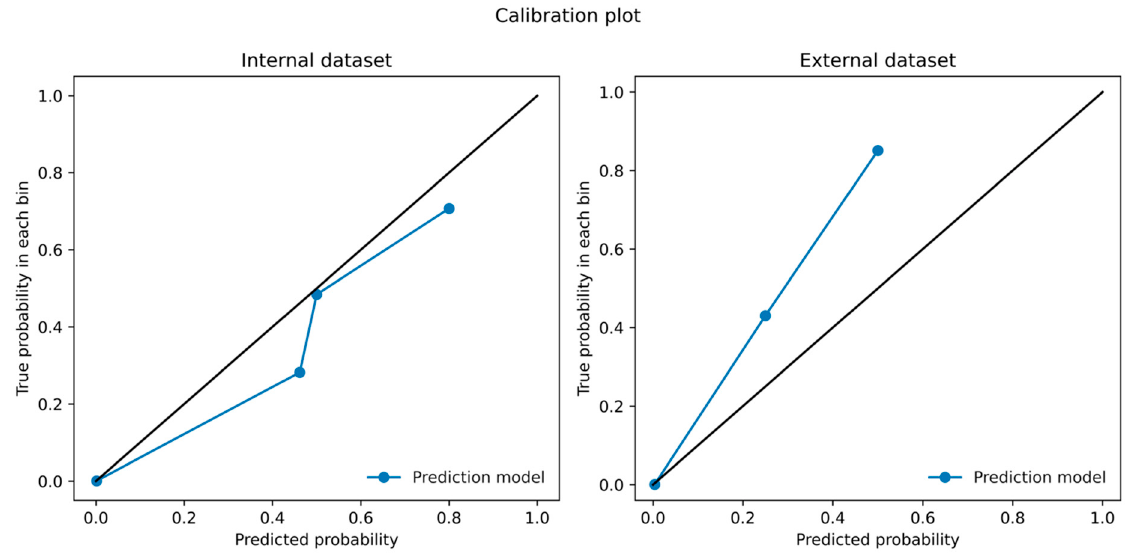
Figure 2. AUROC (area under the receiver operating characteristic curve) and AUPRC (area under the precision and recall curve) plots in the internal validation test set (Samsung medical center) and external validation dataset (Ajou university medical center). XGB (extreme gradient boosting algo ‐ rithm) denotes the main model of our study based on various variables from preoperative evalua ‐ tion sheets. Baseline denotes logistic regression model with only sex, age, weight, height, American Society of Anesthesiologists (ASA) class, and underlying disease.